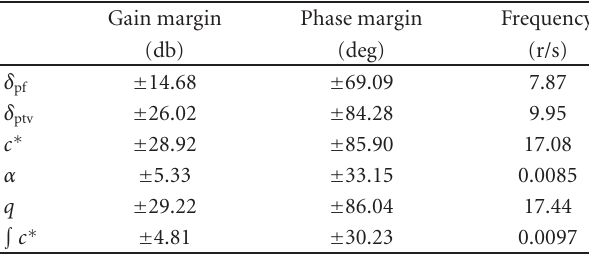
Table 7: Longitudinal gain/phase margins a